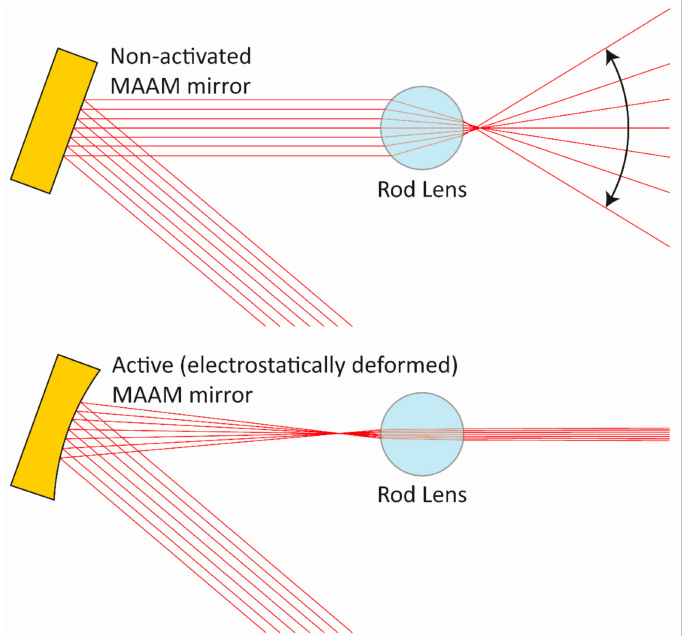
Figure 1. Use of the micro-electronic-mechanical system-based adaptive astigmatic membrane (MAAM) mirror in a laser line setup with a variable fan angle (schematic top view): with a non- activated flat MAAM mirror ( top ), the full aperture of the rod lens is illuminated and leads to a wide fan angle. Focussing ( bottom ) illuminates a smaller section of the rod lens, leading to a smaller fan